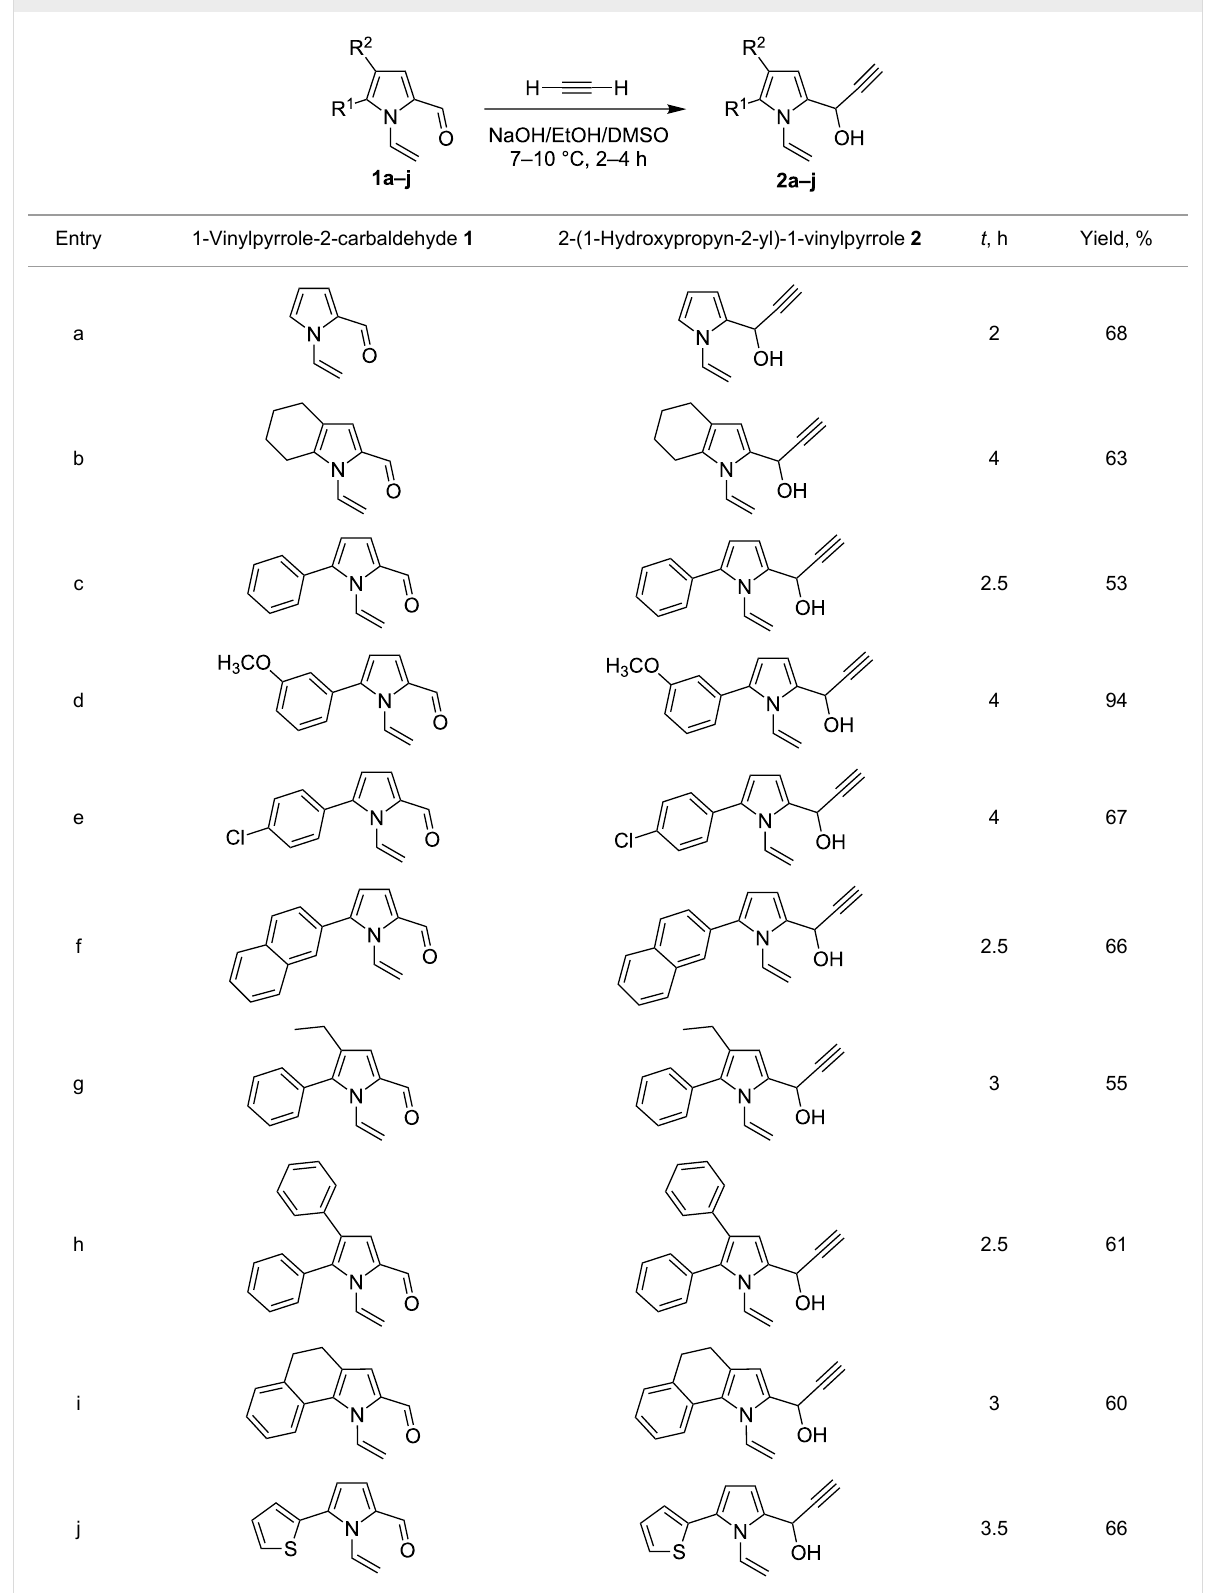
Table 1: Synthesis of 2-(1-hydroxypropyn-2-yl)-1-vinylpyrroles 2a–j